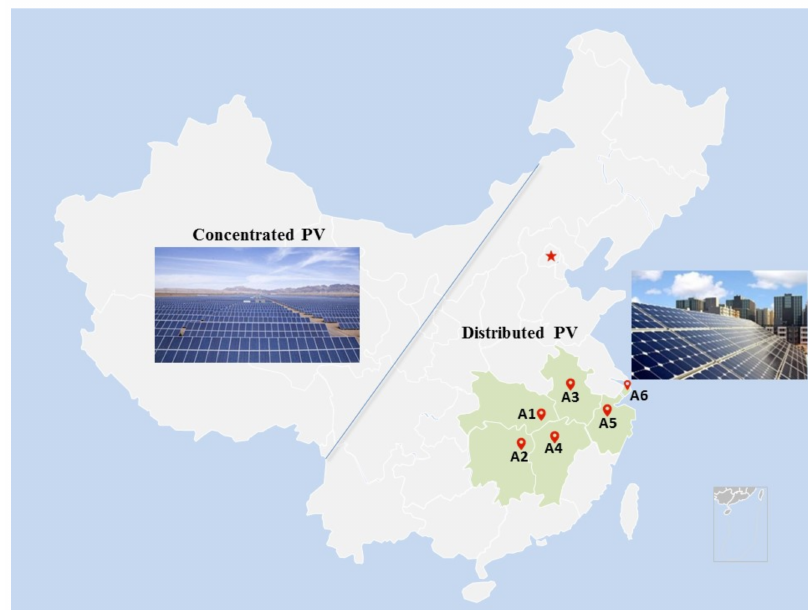
Figure 6. Distribution of the alternative projects.